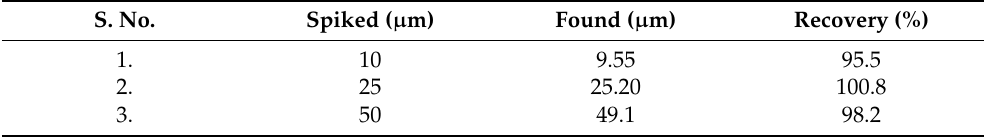
Table 2. Percentage recovery of Cys into spiked samples by using MPTMS@Gd 2 O 3 NPs. S.